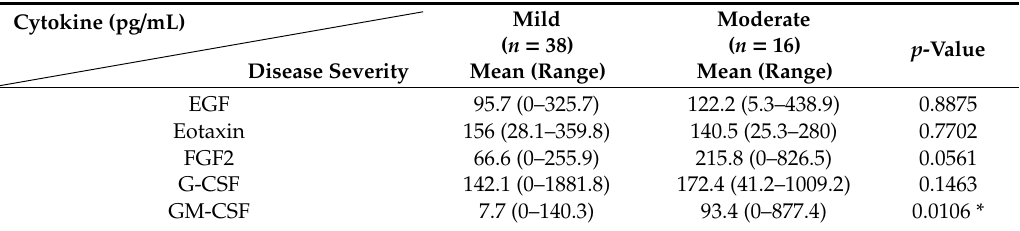
Table 3. Serum inflammatory mediators’ levels (cytokines, chemokines and growth factors) in patients with CDI divided into mild and moderate CDI